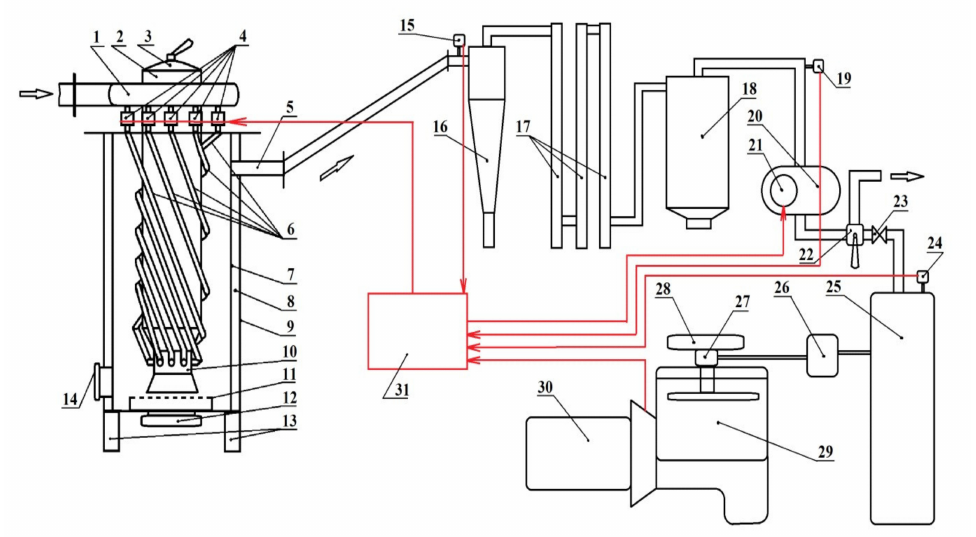
Figure 1. Diagram of gas generator system cooperating with reciprocating IC engine- own